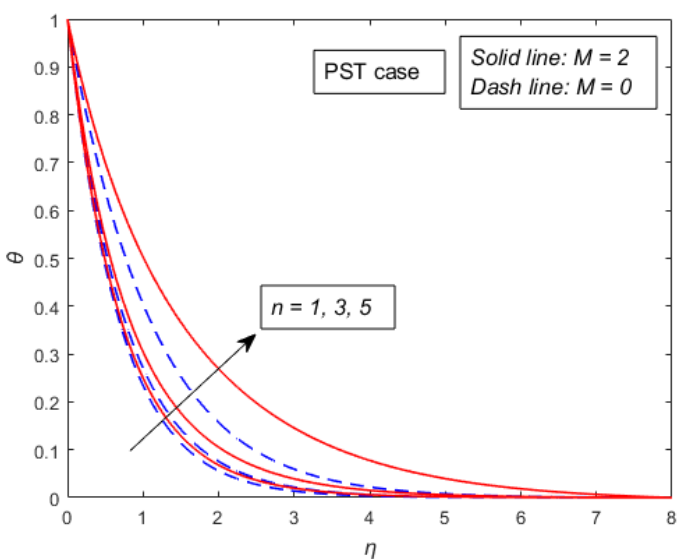
Figure 3. Variation of the temperature profile for different values of nonlinear stretching sheet parameter n and magnetic parameter M for the prescribed surface temperature (PST) case when K = 1, Pr = 0.71, and Ec = 0.1.